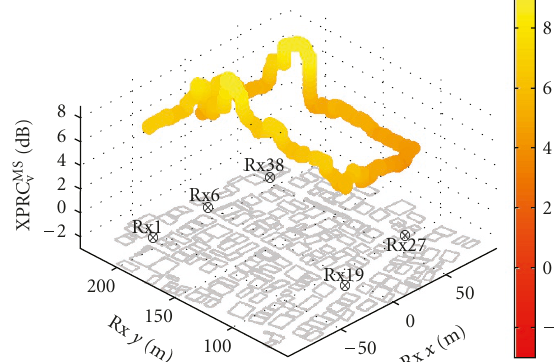
of the DMCs Δ s = 20 (ca 3m). h